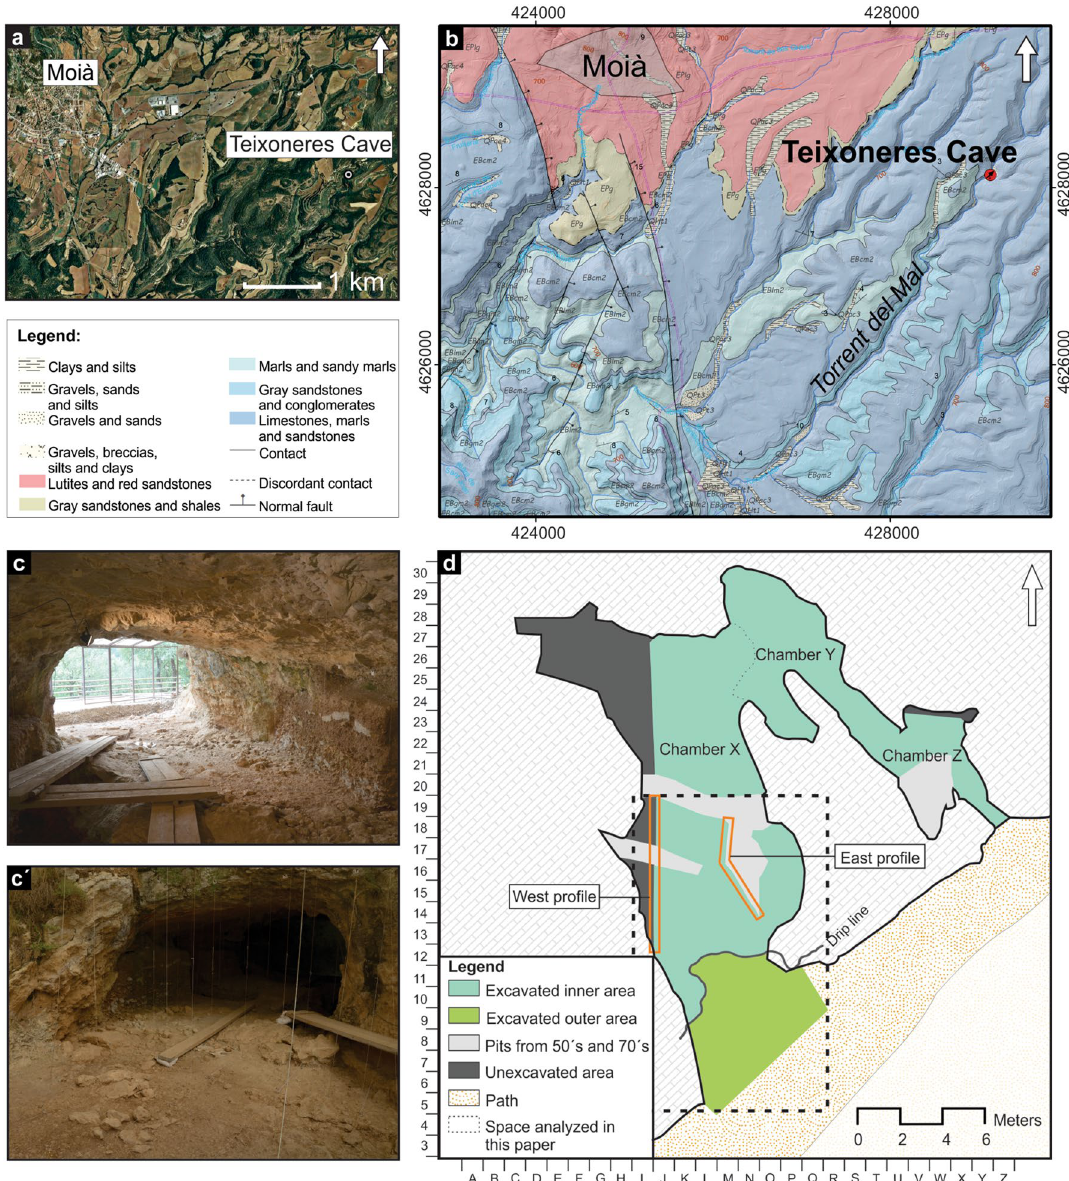
://www.icgc.cat/Desca rregu es/Imatg es-aerie s-i-de-satel -lit/Ortoi matge s-Senti nel-2] and ( b ) [https ://www.icgc. cat/Admin istra cio-i-empre sa/Desca rregu es/Carto grafi a-geolo gica-i-geote matic a/Carto grafi a-geolo gica/GT-I.- Mapa-geolo gic-1-25.000], used under a CC BY 4.0 license. ( c – c ′ ) View of the archaeological site during the 2017 field season. ( d ) The ground plan and grid system of the excavation was registered by means of a Trimble S6 total station (GPS Trimble R6 and GPS TwoNavSportiva receptors) and using VRS (Virtual References Station) technique. The images were prepared with the Adobe Photoshop CS5 Version 12.0.4